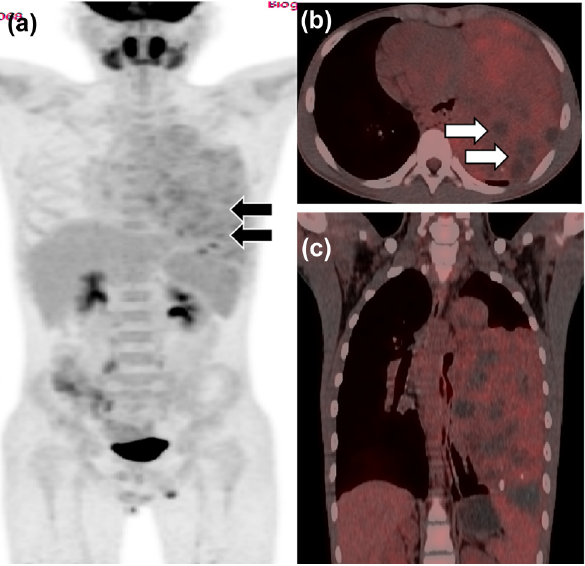
Figure 4: ( a ) PET/CT examination of the patient with mediastinal MGCT after chemotherapy; whole - body MIP ( maximum density projection ) images showed large patches of slightly increased radioactivity uptake in the left lung fi eld ( black arrow ) , SUVmax 5.2. ( b ) Axial PET/CT fusion images showed varying levels of uptake of radioactive tracers in the lesions, but no uptake in the cystic necrosis area ( white arrow ) . ( c ) Coronal PET/CT fusion image.